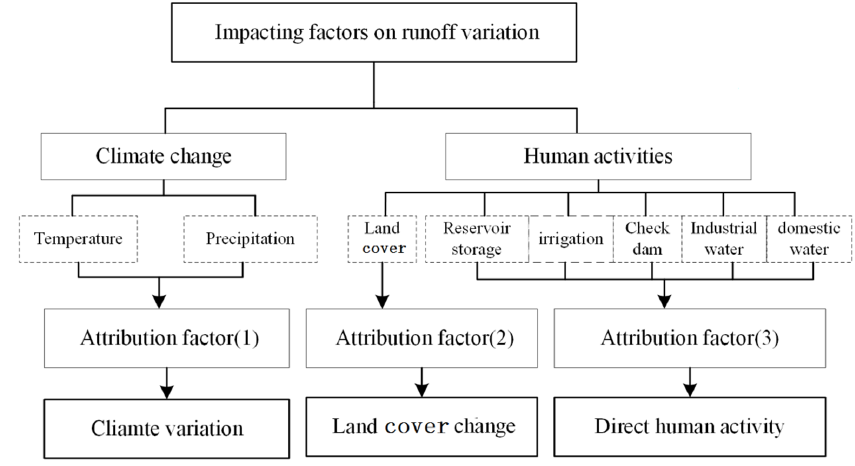
Figure 1. Classification of factors that influence runoff.